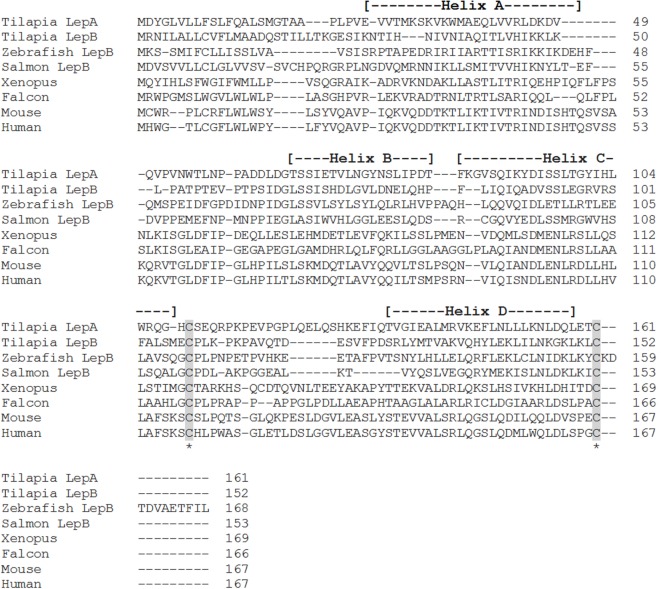
Alignment of teleost leptin B (LepB) with the leptin homologs from other vertebrate classes, tilapia leptin A (LepA), has been included for comparison. Accession numbers: tilapia LepA, AHL37667.1; tilapia LepB, AHL37668.1; salmon LepB, NP_001266063.1; zebrafish LepB, NP_001025357.2; Xenopus, NP_001089183.1; falcon, NP_001298279.1; mouse, NP_032519.1; human, NP_000221.1. Shaded areas represent the conserved cysteine residues required for the formation of the disulfide bridge. The four alpha-helices are indicated by dashed lines within the parentheses.